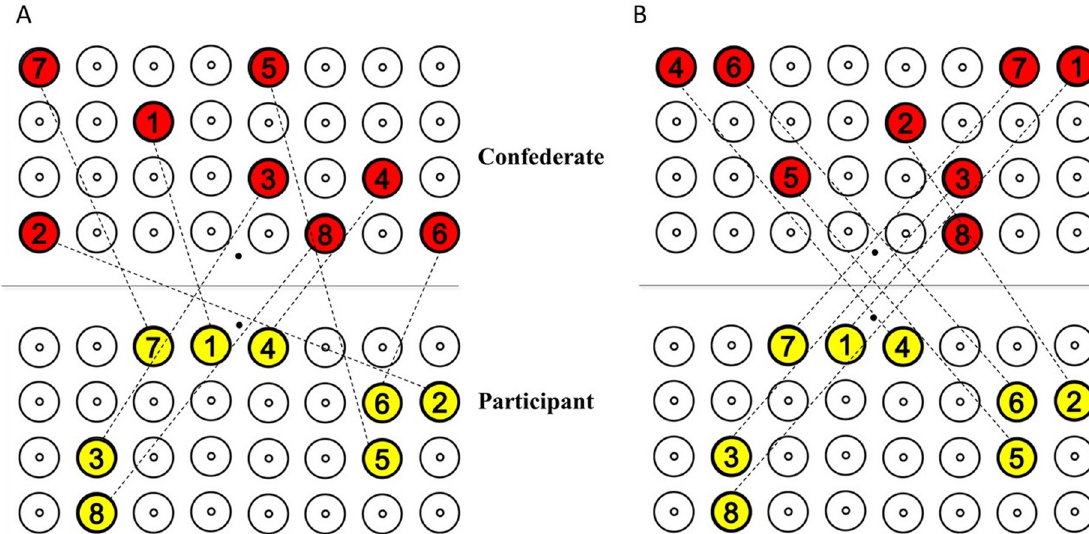
Fig 2. Example of a HV and LV sequence. Red circles denote confederate’s targets and yellow circles denote participant’s targets. Black dashed lines represent various target configurations within the sequence. (A) High variability sequence with varying inter-personal distances across all eight configurations in a sequence. (B) Low variability sequence with similar inter-personal distance across all eight configurations. Average inter-personal distances of the configurations for the two groups are the same. Participants in the HV and LV group received the same targets. Confederate’s target locations were manipulated to produce sequences with different degrees of variability and predictability.